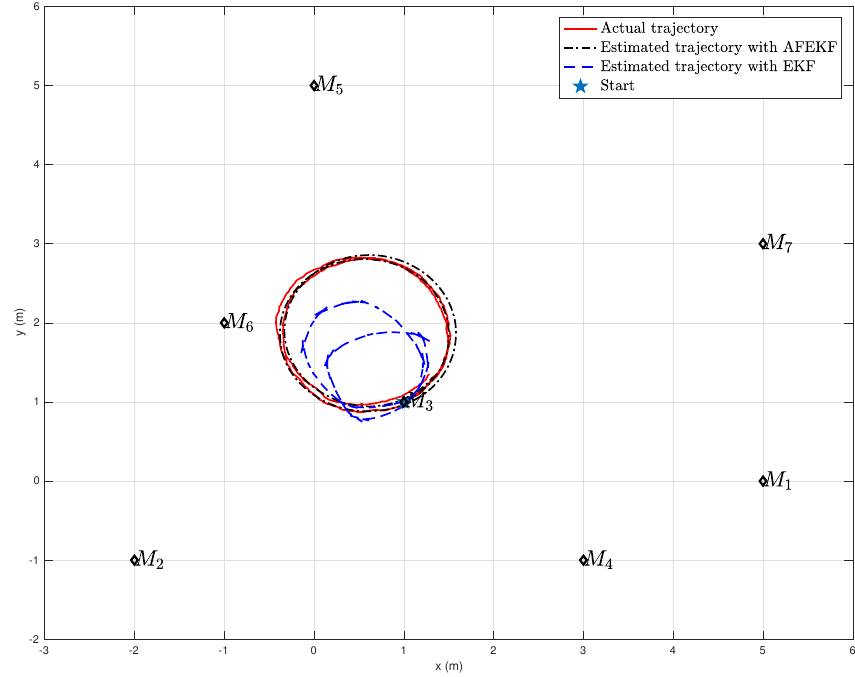
Figure 6. Robot’s trajectory and its estimates under stochastic